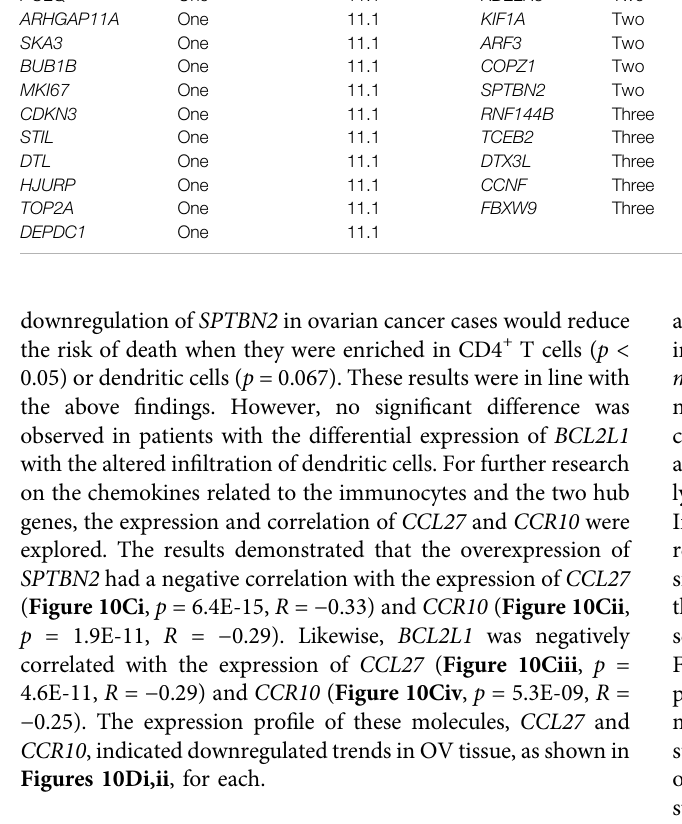
( Figure 10Ci , p (cid:2) 6.4E-15, R (cid:2) − 0.33) and CCR10 ( Figure 10Cii , p (cid:2) 1.9E-11, R (cid:2) − 0.29). Likewise, BCL2L1 was negatively correlated with the expression of CCL27 ( Figure 10Ciii , p (cid:2) 4.6E-11, R (cid:2) − 0.29) and CCR10 ( Figure 10Civ , p (cid:2) 5.3E-09, R (cid:2) −